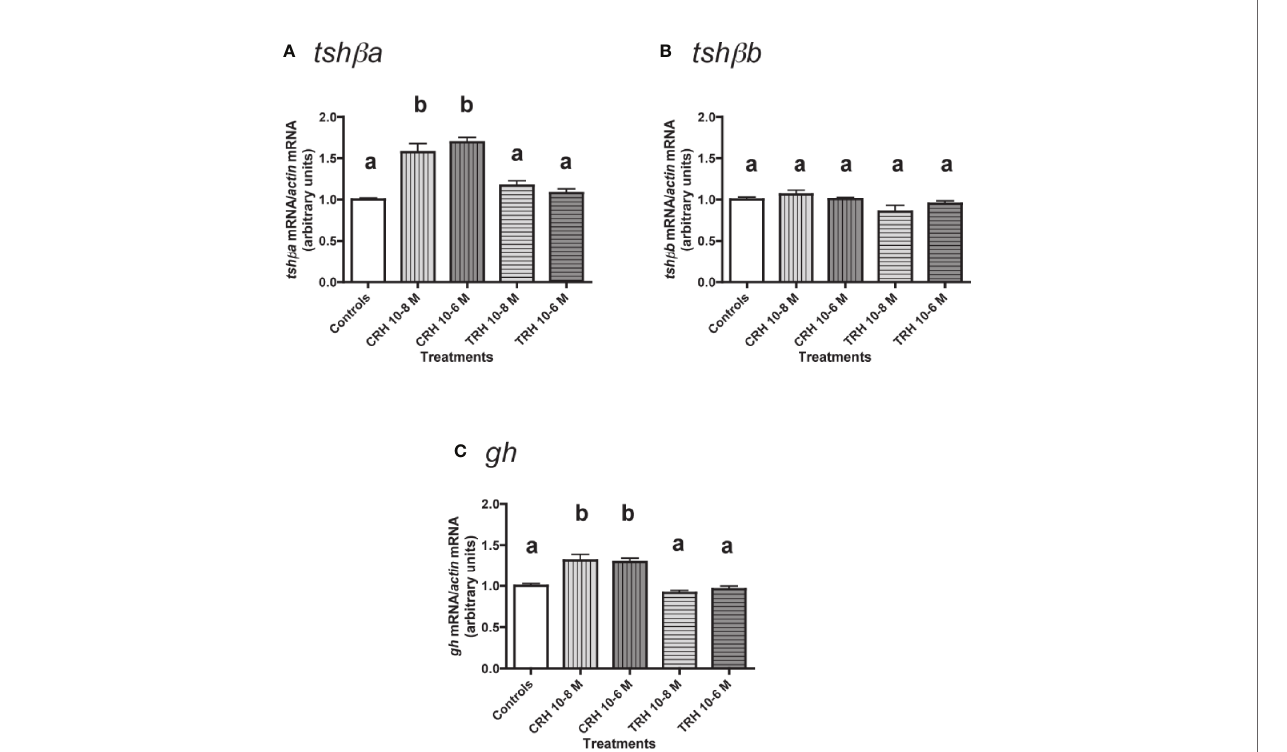
FIGURE 3 | Effects of CRH and TRH on tsh b a , tsh b b , and gh transcript levels in primary cultures of Atlantic salmon pituitary cells. Pituitary cells from juvenile Atlantic salmons were treated with 10 -8 and 10 -6 M of CRH or TRH for 10 days. The mRNA levels of tsh b a (A) , tsh b b (B) , and gh (C) were quanti fi ed by qPCR. Data were normalized against b -actin . The Figure displays the results from a representative experiment of three independent cell culture experiments. Mean ± SEM; n = 5 well replicates. Different letters indicate signi fi cant differences,